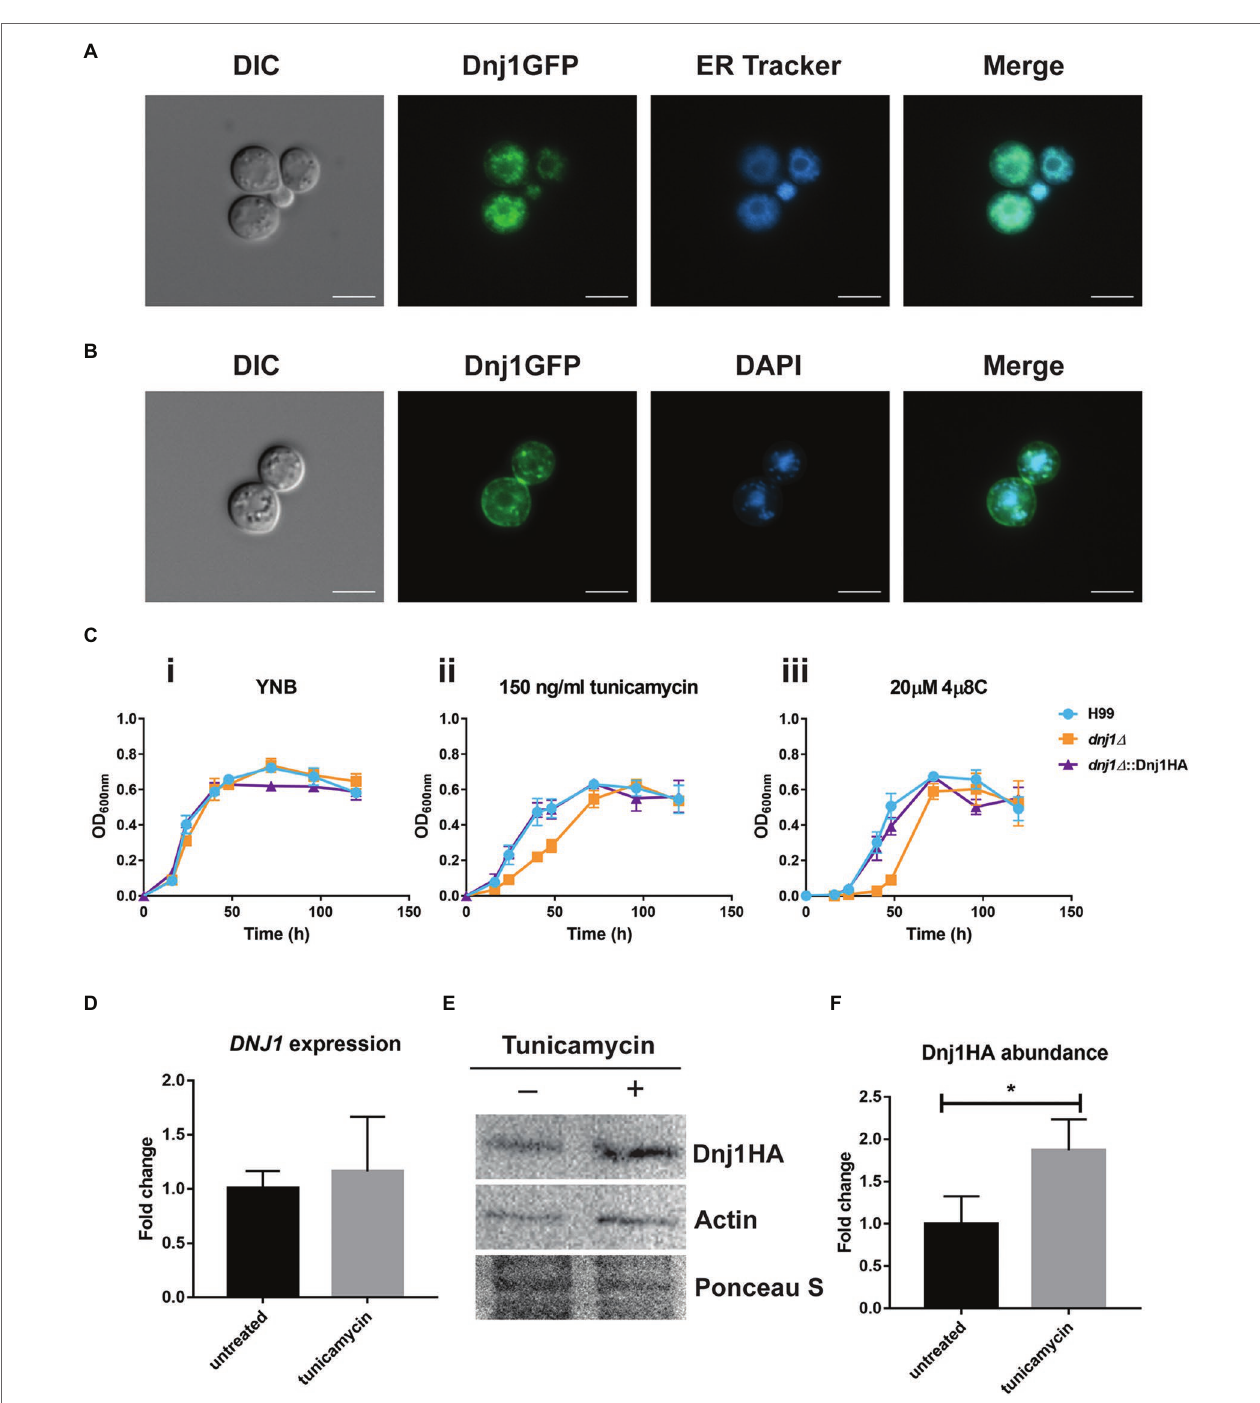
FIGURE 2 | Dnj1 is localized to the endoplasmic reticulum (ER) and is responsive to ER perturbing agents. (A) A strain expressing a C-terminally GFP tagged Dnj1 protein was stained with ER-Tracker ™ to assess co-localization. (B) To confirm that the ring of fluorescence consistently visualized in the Dnj1-GFP expressing strains was perinuclear ER, the DNA in nuclei was stained with DAPI. Bar = 5 μ m. All microscopy images are representative of at least 20 images. (C) Growth curves in liquid YNB + 0.5% dextrose supplemented with ER inhibitors revealed hypersensitivity of the deletion mutant dnj1 ∆ to 150 ng/ml tunicamycin (TM) and to 20 μ M 4 μ 8C compared to the wild type (H99) or complemented strain ( dnj1 ∆ ::Dnj1HA). The error bars represent the SD of three biological replicates. (D) RT-qPCR demonstrating the expression of DNJ1 in response to treatment with 250 ng/ml tunicamycin for 1 h. (E) Detection of the abundance of Dnj1HA in response to tunicamycin treatment by immunoblot analysis. The blot was probed for actin as well to allow relative quantification and stained with Ponceau S to ensure equal protein loading. This blot is representative of three blots which were quantified in (F) . In both (D) and (F) , bar heights indicate the mean of three replicated and error bars indicate the SD. Statistical significance was determined using unpaired t -tests (* p <